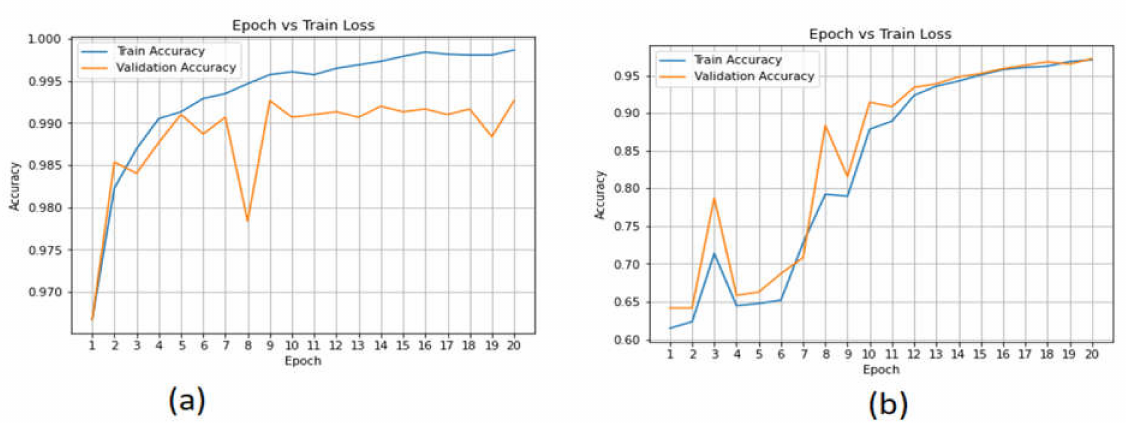
Figure 15. Performance of the deep learning models in the CICAndMal2017 dataset. ( a ) LSTM. ( b ) CNN-LSTM.